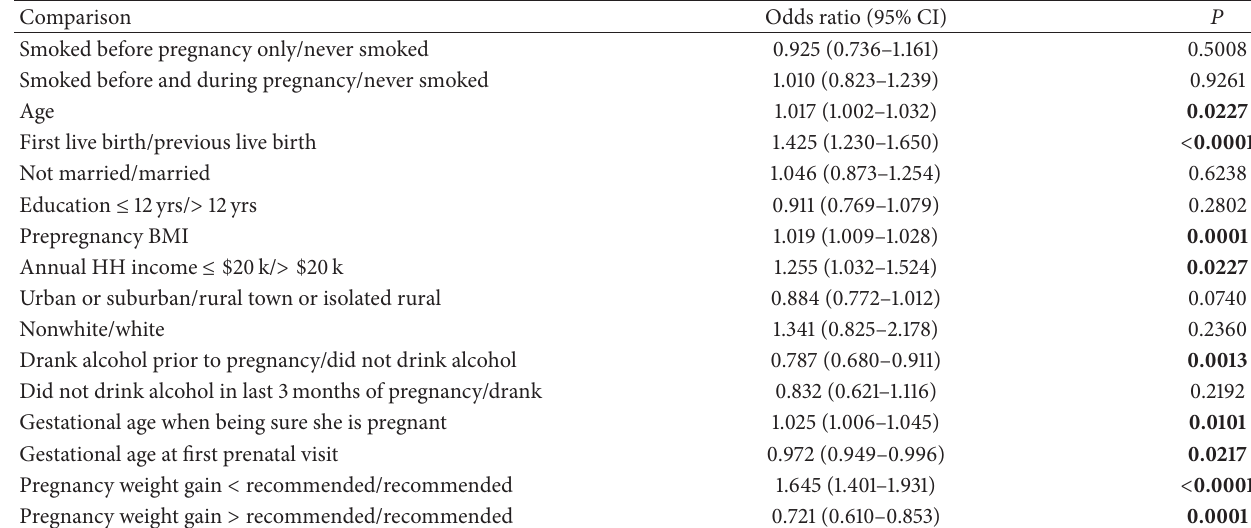
Table 5: Maternal predictors of infant born prematurely ( < 37wks of